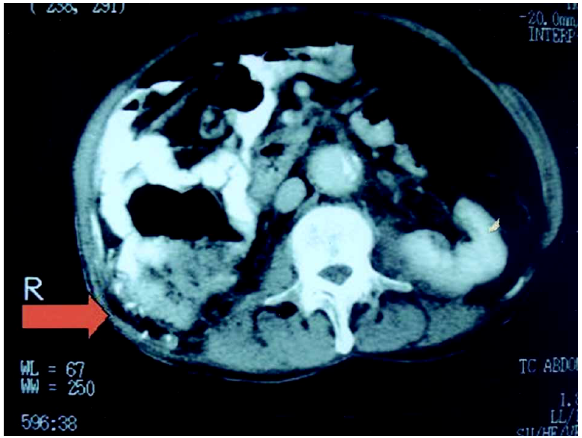
Figure 5 – Control tomography performed 1 year after surgery evidenced good positioning of the clamp-fixed mesh and repair of hernial